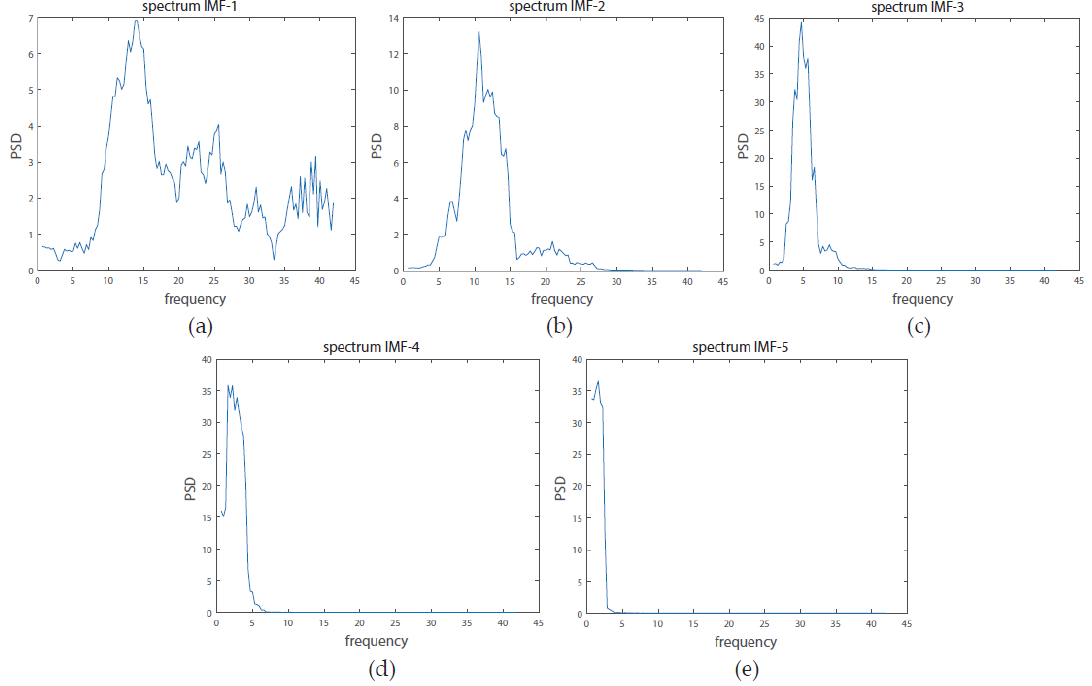
Figure 1. Example of Power Spectral Density (PSD) of the first 5 Intrinsic Mode Functions (IMFs) of one trial from one of the users. ( a )–( e ) respectively represent the first 5 calculated IMFs.